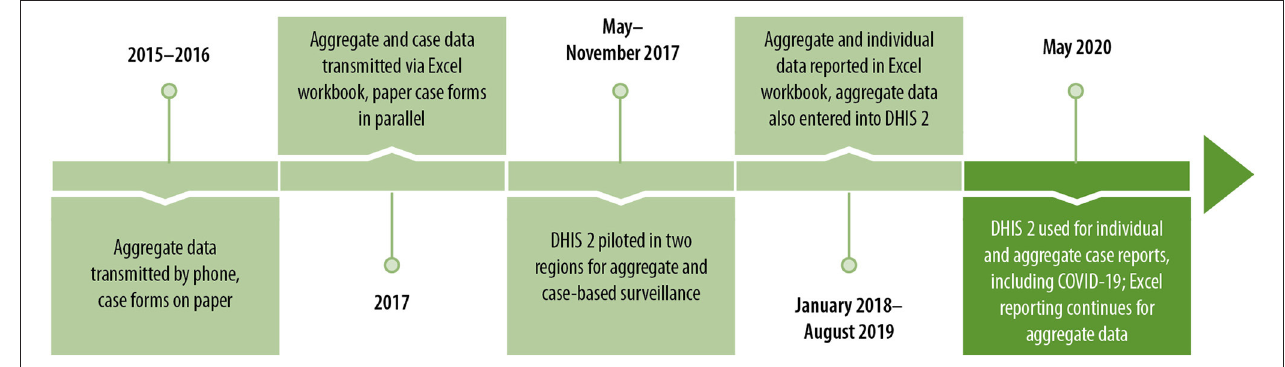
FIGURE 6 | Evolution of disease surveillance in Guinea,